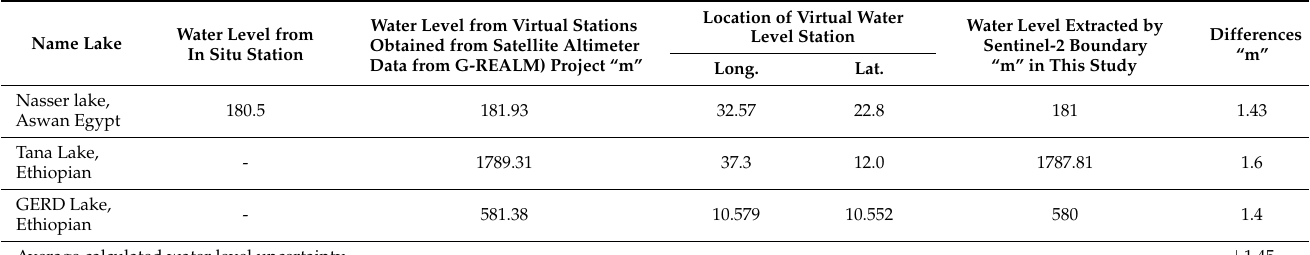
Table 1. Water level for the Aswan, Tana, and GERD